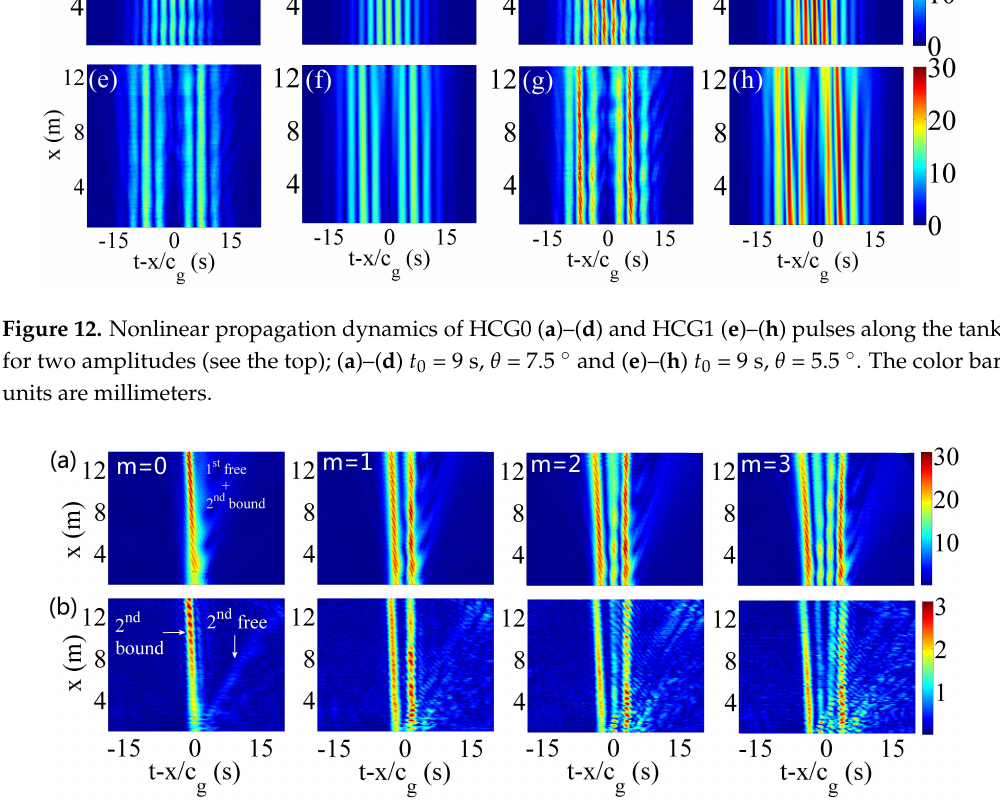
Figure 13. Experimental results for: ( a ) nonlinear propagation of HG pulses and ( b ) the generated second harmonic bound waves with a 0 = 21 mm ( ε = 0.17), t 0 = 2.5 s, and C = 0. Both ( a ) and ( b ) represent the envelope in a moving system. The color bar units are